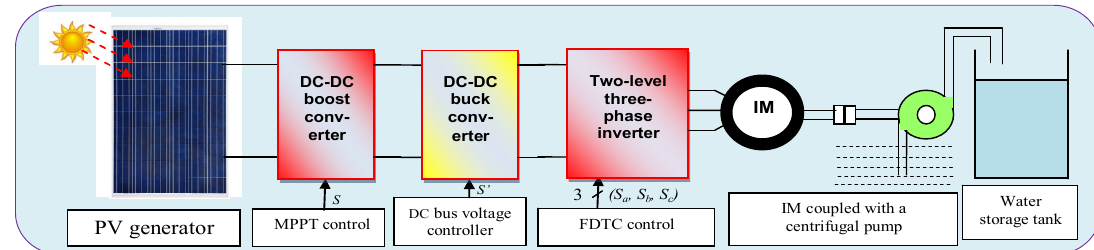
Figure 1. Synoptic scheme of proposed studied system.